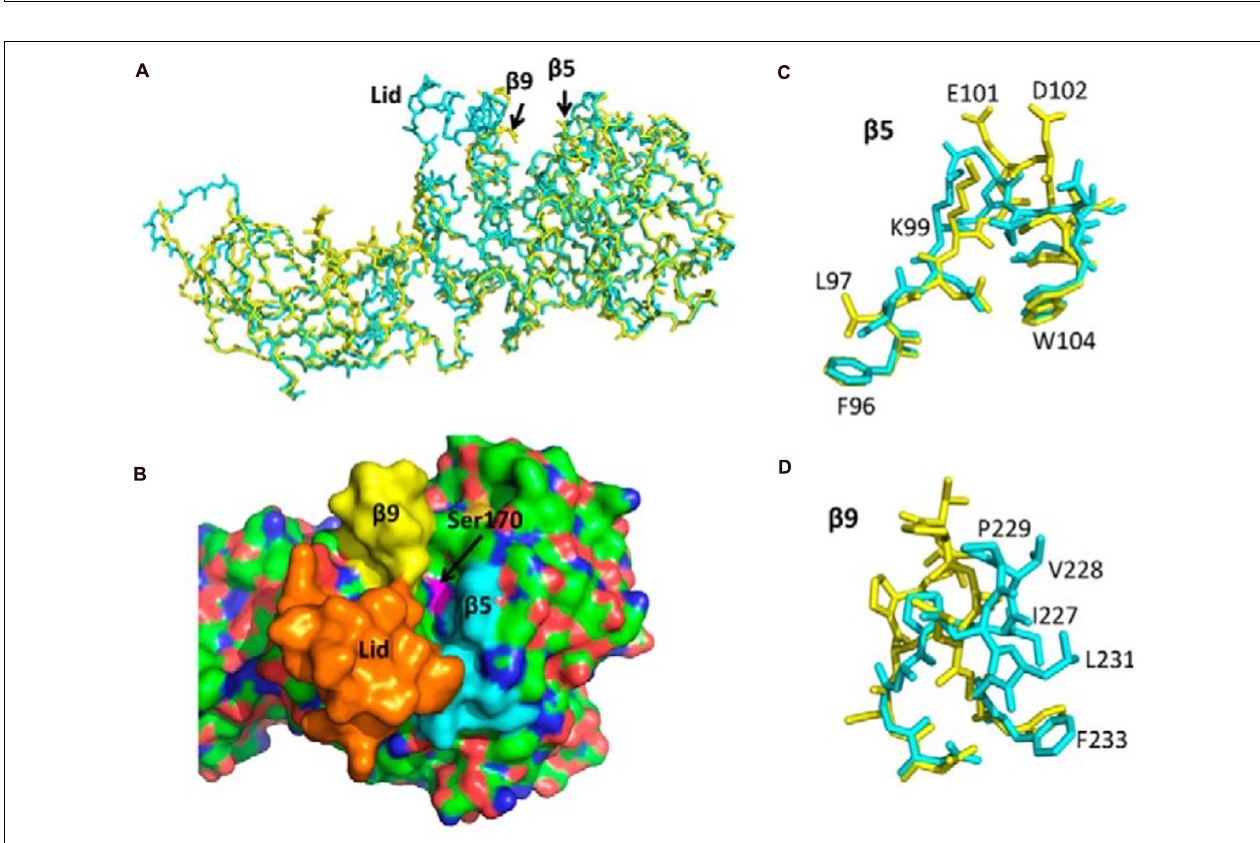
FIGURE 2 | Structure of human PTL (PNLIP) and PLRP2 (PNLIPRP2) and the corresponding lid, β 5, and β 9 loops. (A) Superimposed α -carbon structure of PNLIP (blue) and PNLIPRP2 (yellow). (B) Surface structure of PNLIP showing the catalytic site cavity and the location of the lid domain (orange), β 5 loop (blue), and β 9 loop (yellow). (C) Superimposed β 5 loops of PNLIP (blue) and PNLIPRP2 (yellow). The labeled amino acids are PNLIPRP2 residues. (D) Superimposed β 9 loops of PNLIP (blue) and PNLIPRP2 (yellow). The labeled amino acids are PNLIPRP2 residues. PTL (PNLIP), pancreatic triglyceride lipase; PLRP2 (PNLIPRP2), pancreatic lipase-related protein